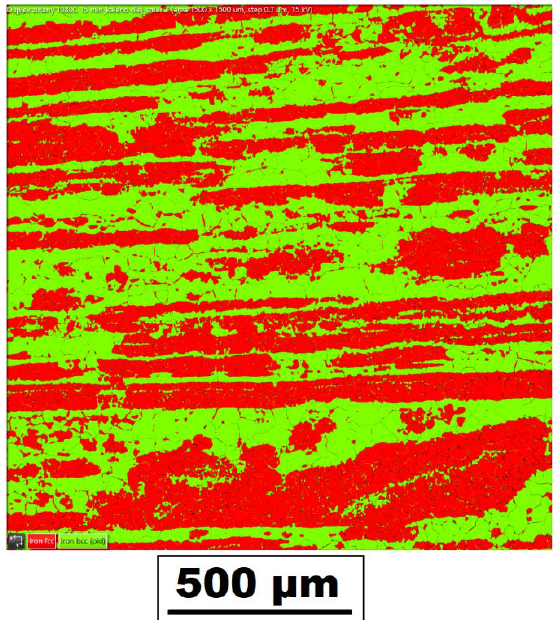
Figure 19. Distribution of ferrite (green) and austenite (red) after annealing at a temperature of 1080 °C with a soaking time of 10 min (t 8/5 = 5.8 s): ferrite, 47.7%; austenite, 50.1%; and non-identified areas, 2.2%.